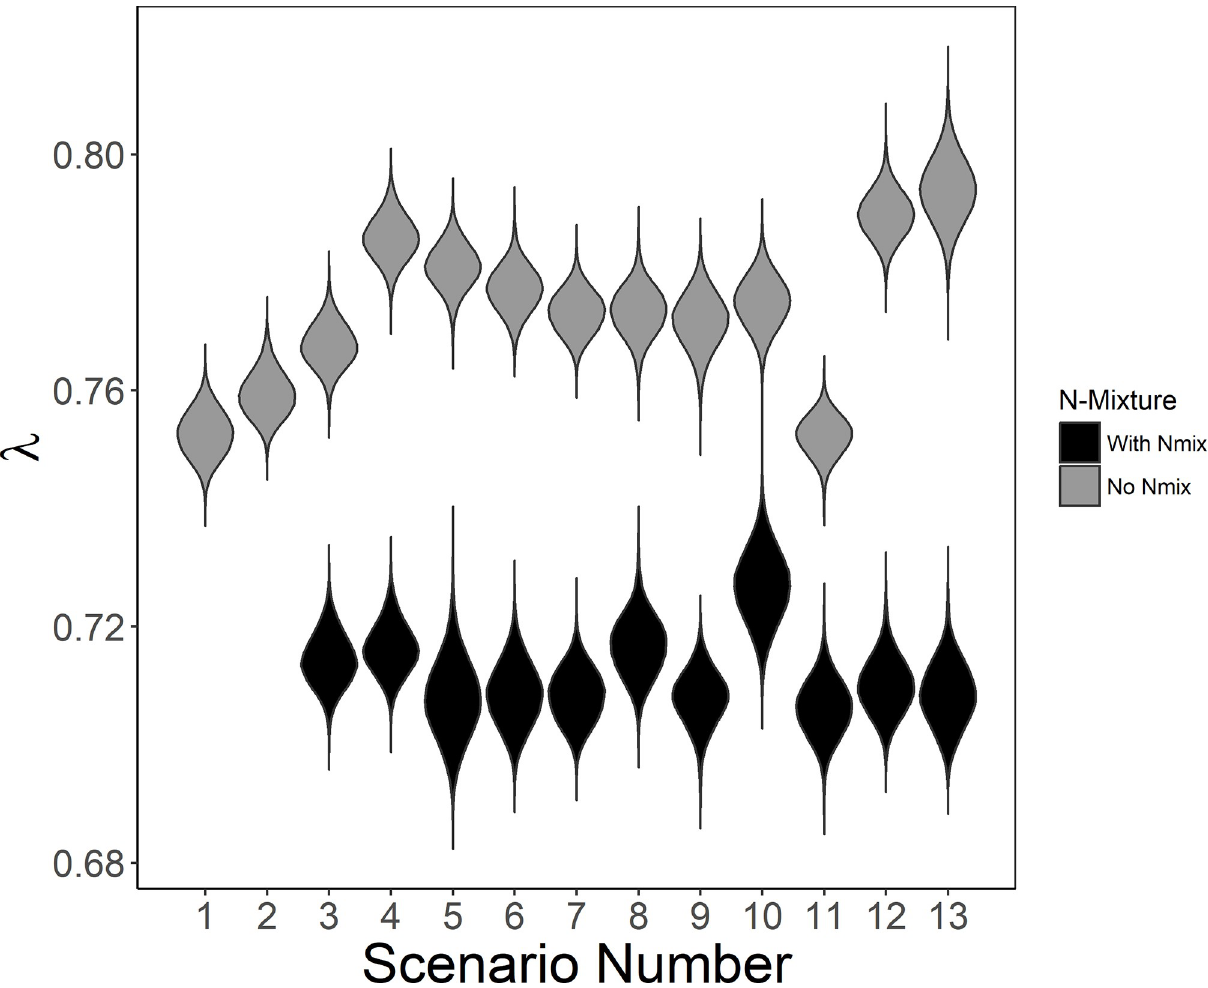
Fig 2. Mean long-term population growth rates ( � λ ) from simulated lek counts of lesser prairie-chickens based on individual-based models with different scenarios (see Table 2). Each violin plot represents all Markov Chain Monte Carlo (MCMC) samples from the 100 simulations combined for the models without the N-mixture model (“No N-mix”, Scenarios 1–13) and with the N-mixture model (“With N-mix”, Scenarios 3N-13N).